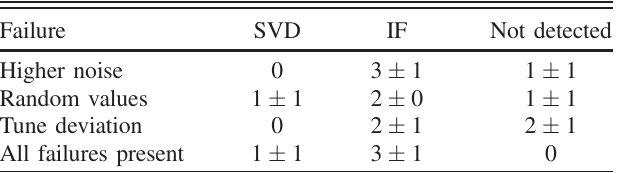
TABLE III. Number of faulty BPMs detected by SVD together with combination of thresholds compared to number of BPMs detected after additionally applying IF on cleaned data. The results are obtained using SVD default cut value 0.925 and IF contamination factor set to 0.02. The numbers are averaged over 20 simulated measurements. The basic zero cut failures are not included into comparison.